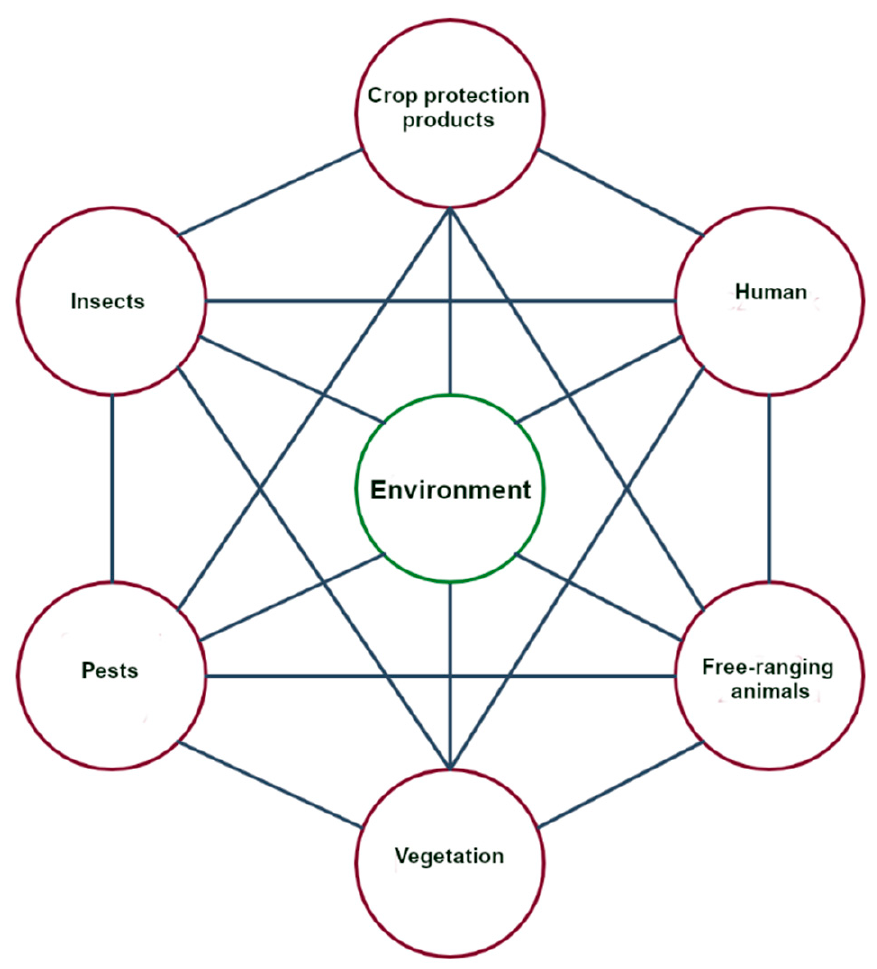
Figure 4. Model of environmental interactions.